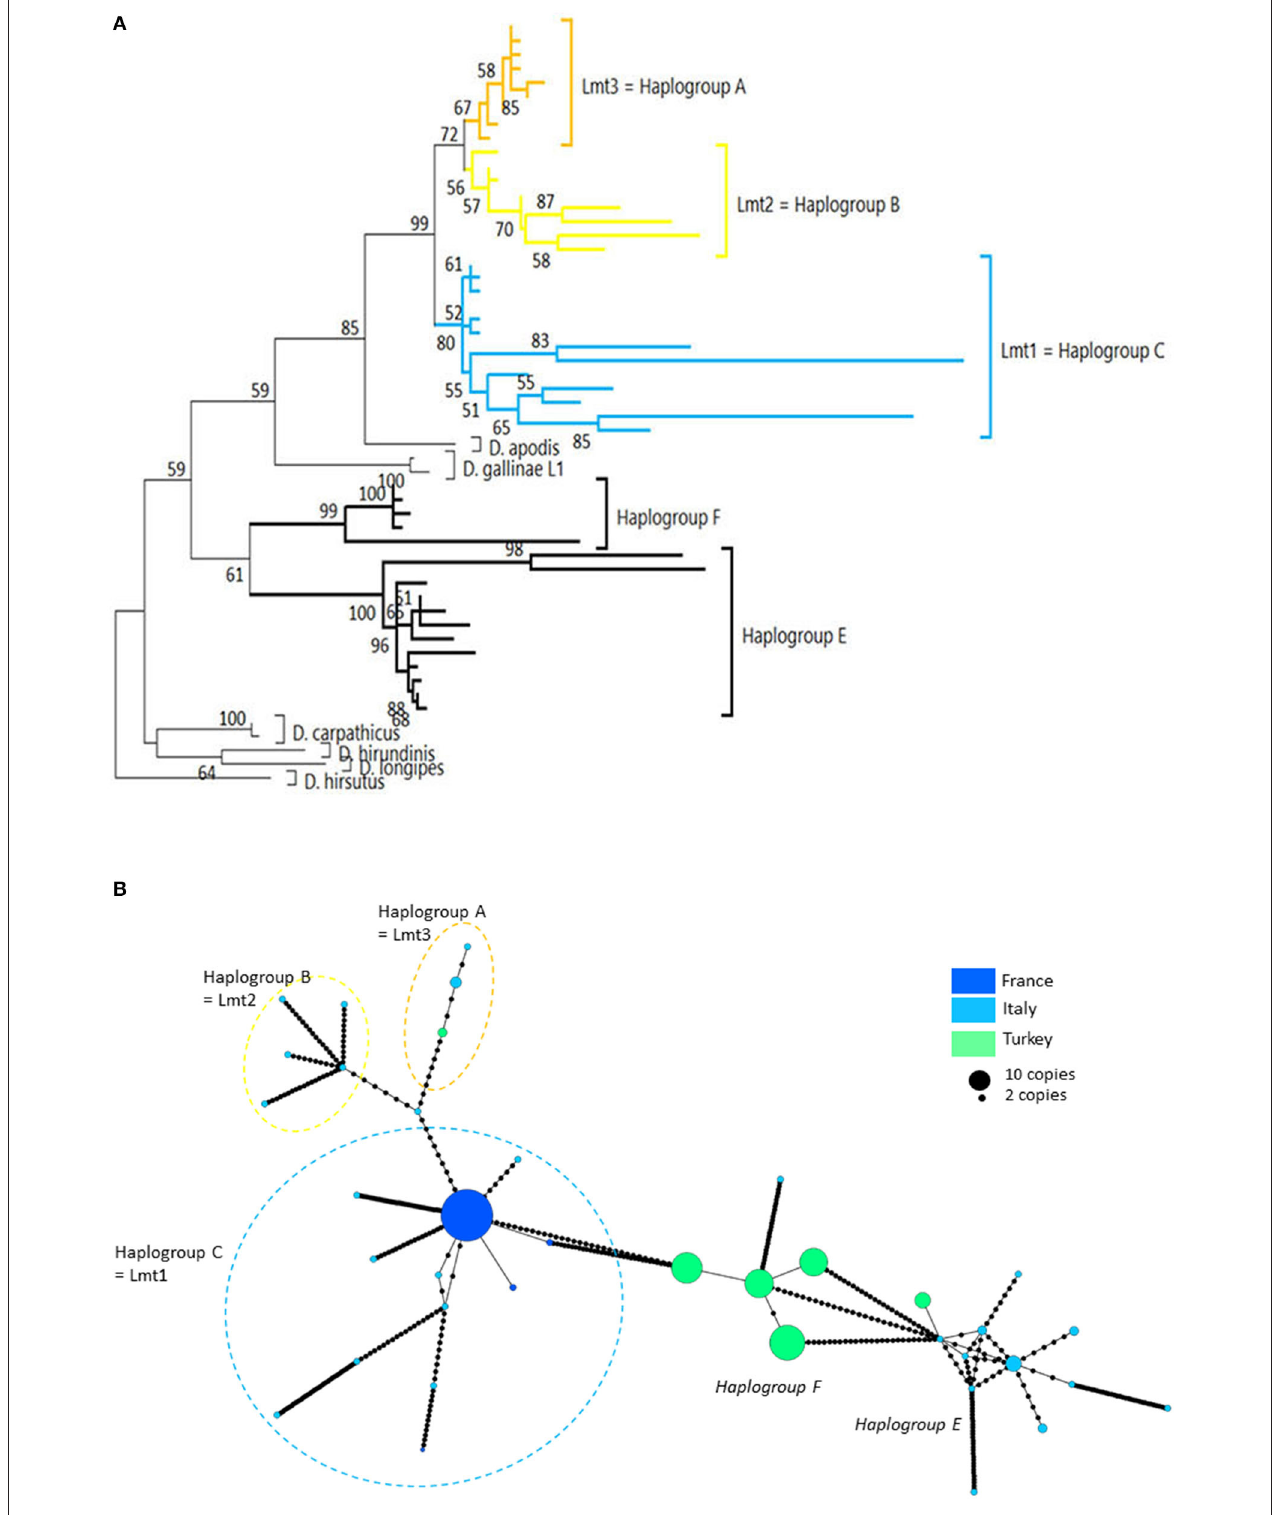
FIGURE 4 | Genetic structure from CO1 haplotypes on region 2. (A) Evolutionary history of Dermanyssus gallinae s.l. CO1 haplotypes based on all available data on the region 2 of CO1 (273 bp) using the Tamura 3-parameter model (52), with sequences of other Dermanyssus species as outgroups ( D. apodis , D. carpathicus